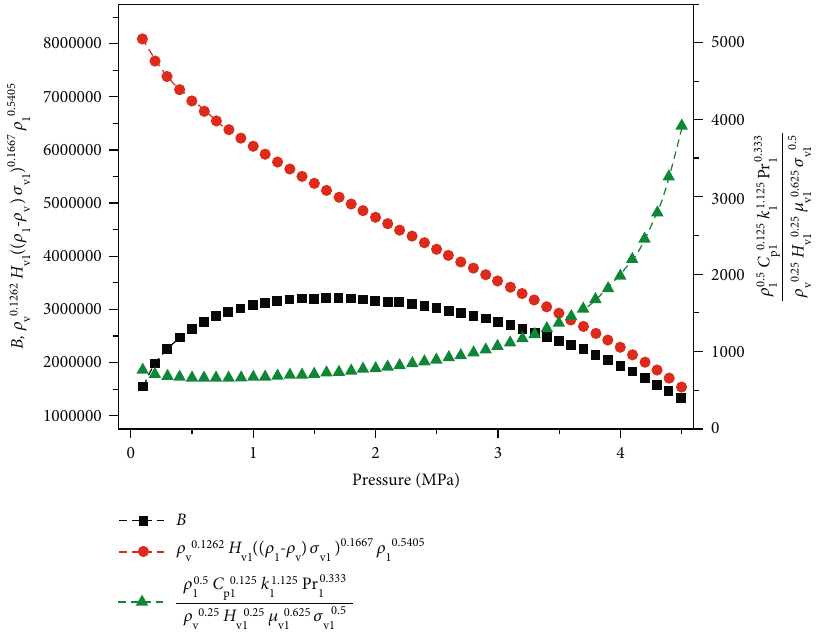
Figure 23: Pressure versus parameter combinations for